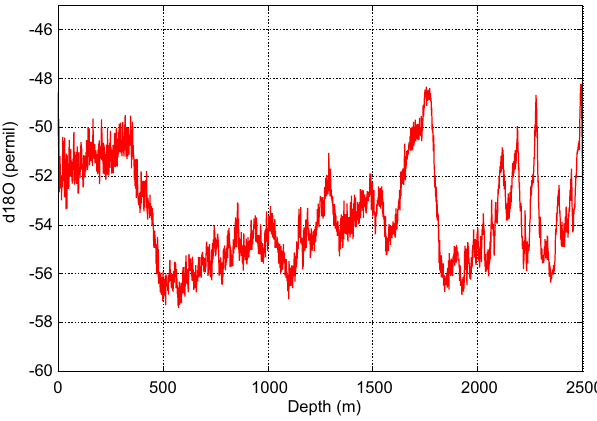
Figure 1. δ 18 O data used in this